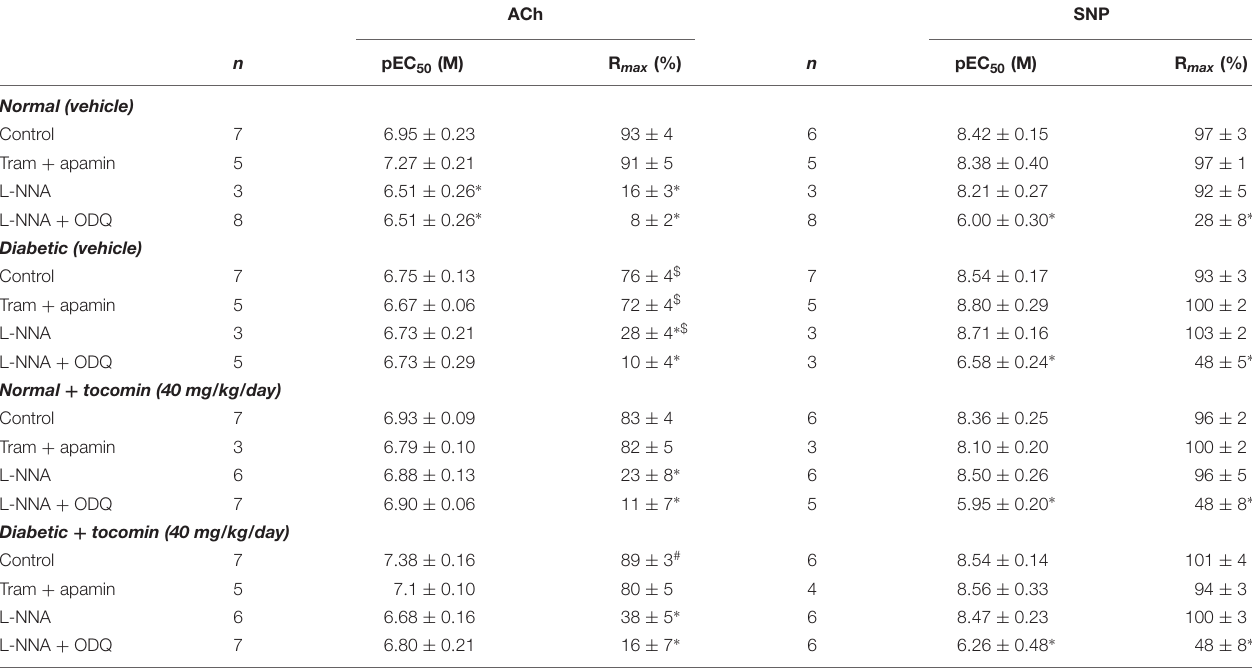
TABLE 2 | The effect of 4-week tocomin treatment on ACh-induced endothelium-dependent and SNP-induced endothelium-independent relaxation of rat aortae during